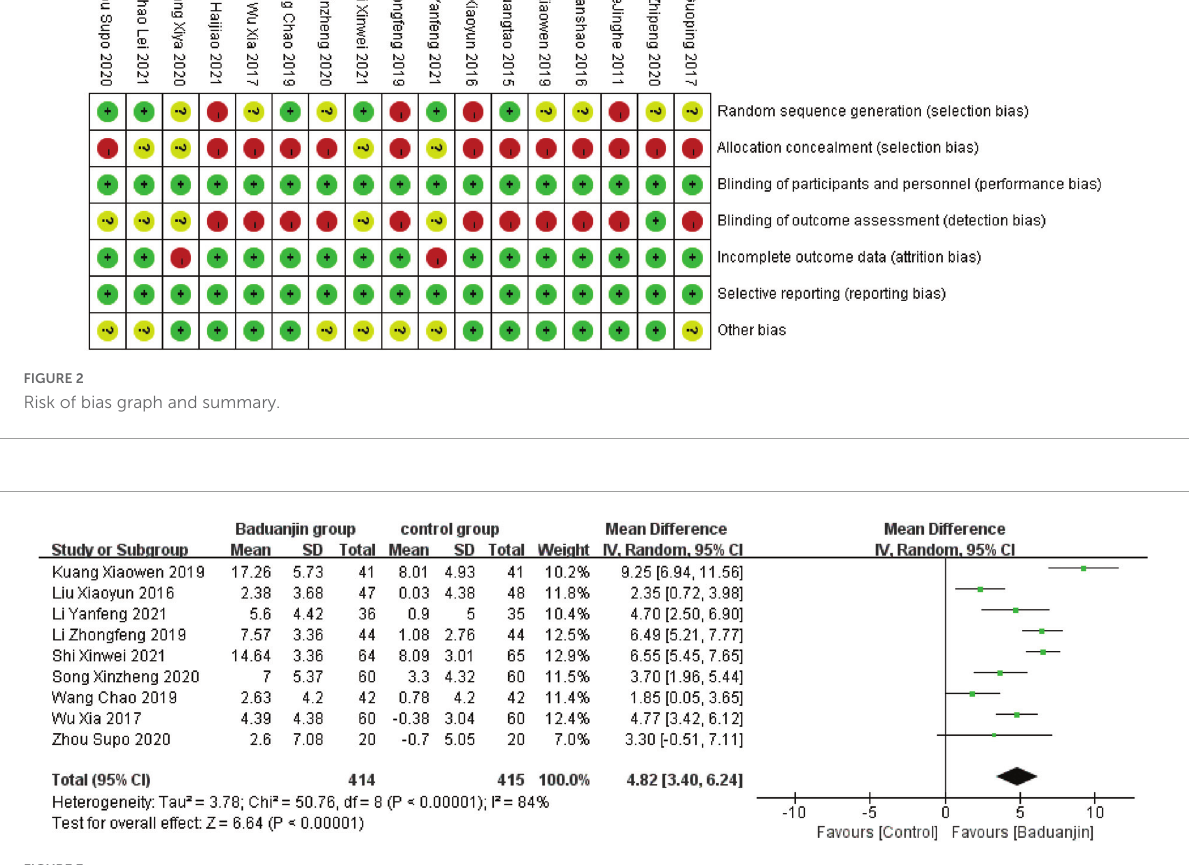
the parameter of BBS, the subgroup pool effect size increased with the increase of total exercise amount, and there was the significant difference between SE and LE as shown in Figure 9